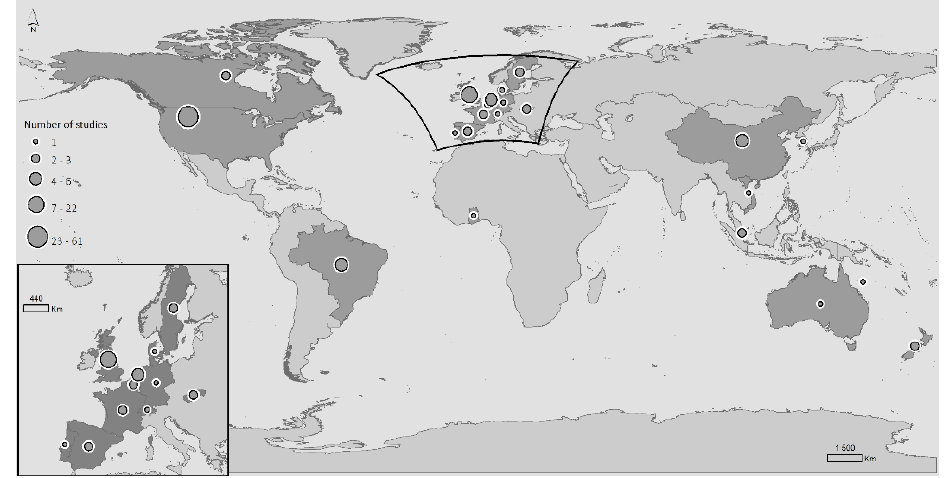
Figure 3. Distribution by country of the number of studies that assessed the association between healthy ageing and neighbourhood socioeconomic processes and dynamics.